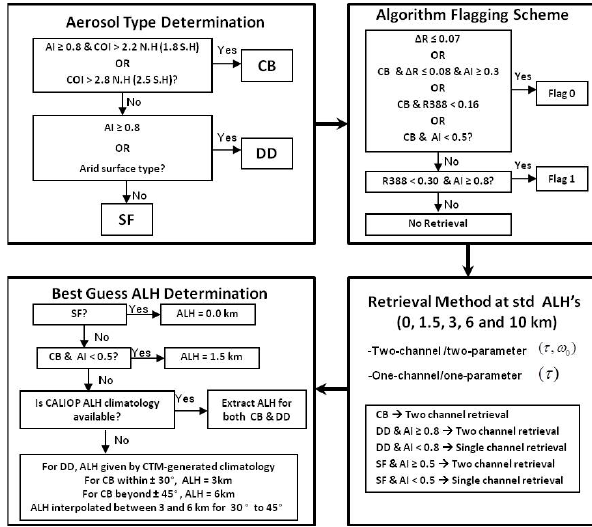
Fig. 1. Graphic description of OMAERUV inversion